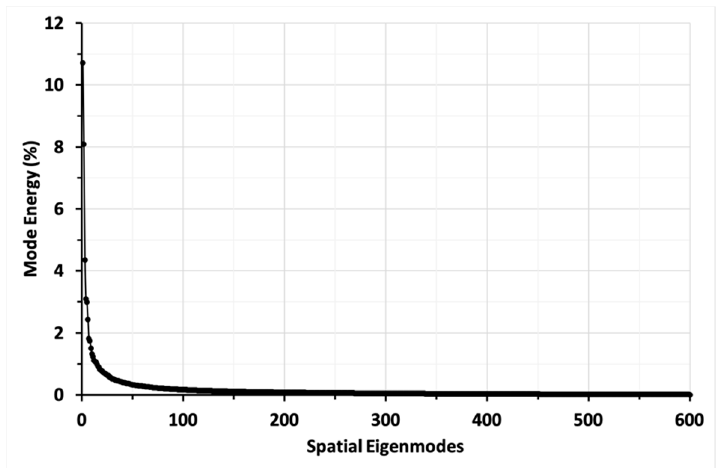
Figure 18. Mode energy at different spatial Eigenmodes.